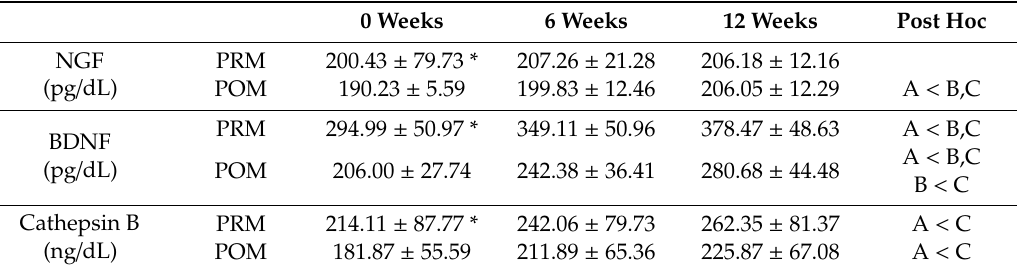
Table 6. Changes in neuroplasticity factors after exercise